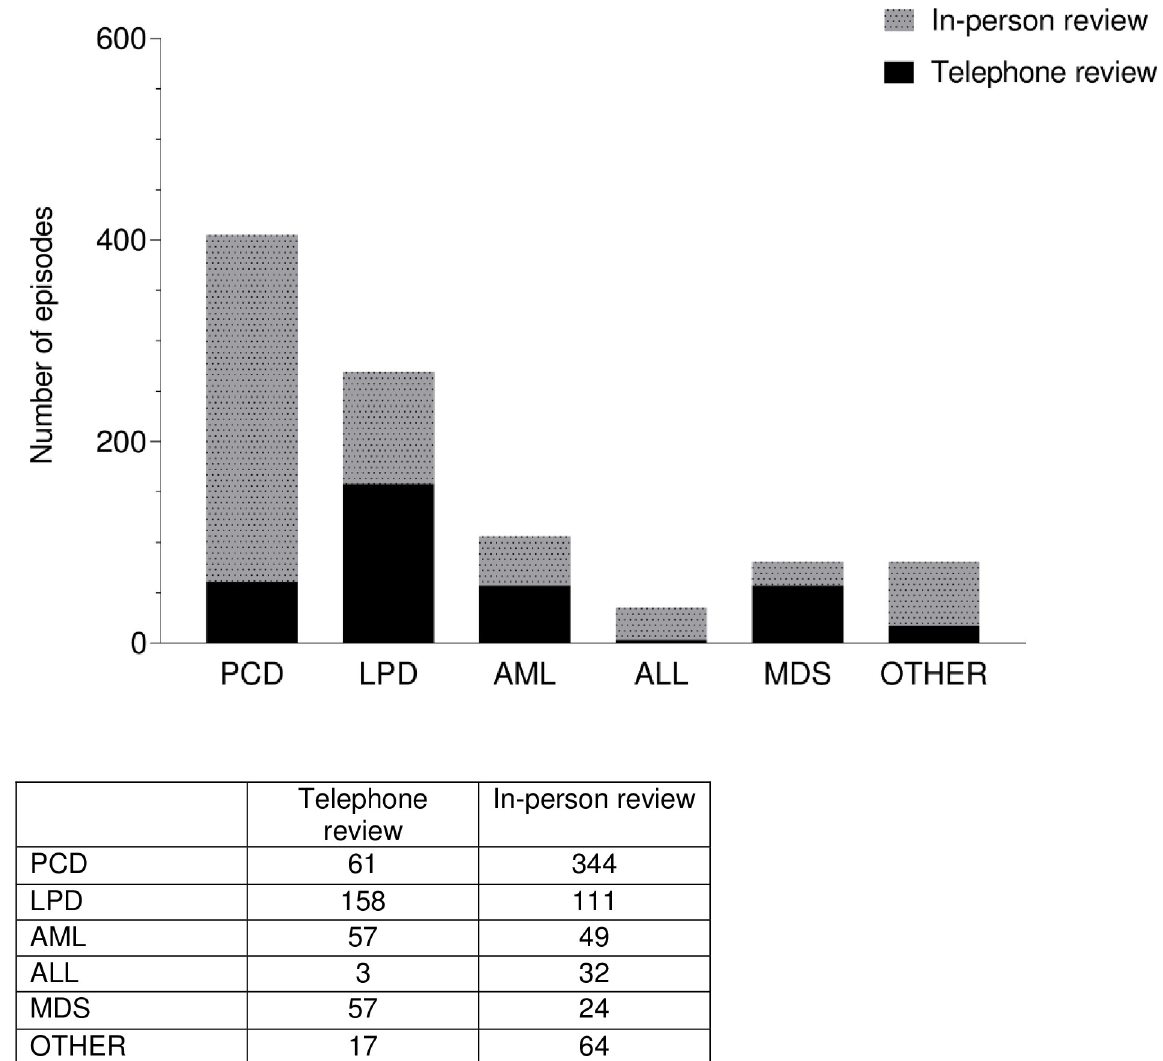
Fig 2. Patients reviewed on day-case basis in person (n = 624) and telephone review (n = 353) during the study period according to disease type.